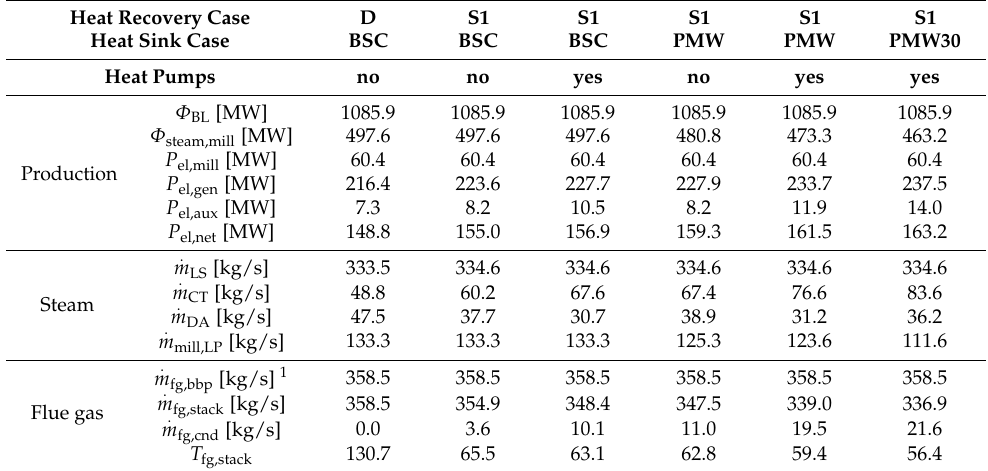
Table 3. Simulation results for S1 type heat recovery scrubber with different heat sink